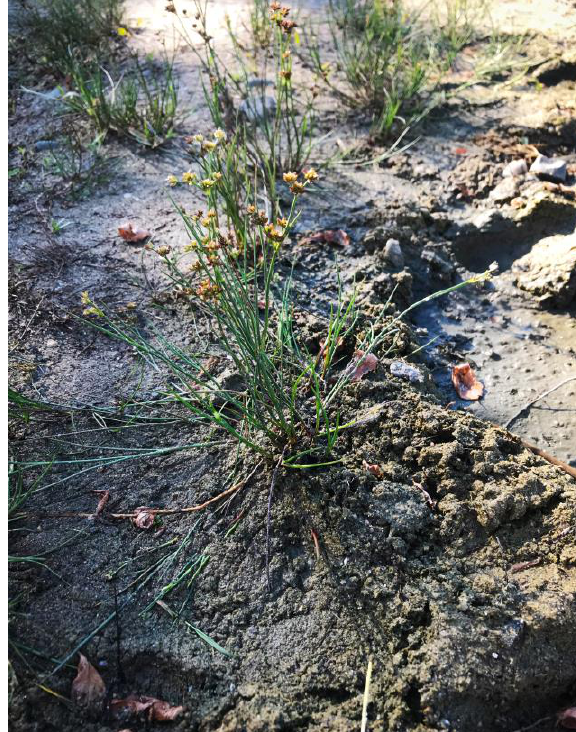
Fig. 3. Pulicario vulgaris-Menthetum pulegii on the floodplain meadow-pasture near the village of Rakoshyno (Mukachevo district, Zakarpattia region, 2015) (Photo by L. Felbaba- Klushyna)